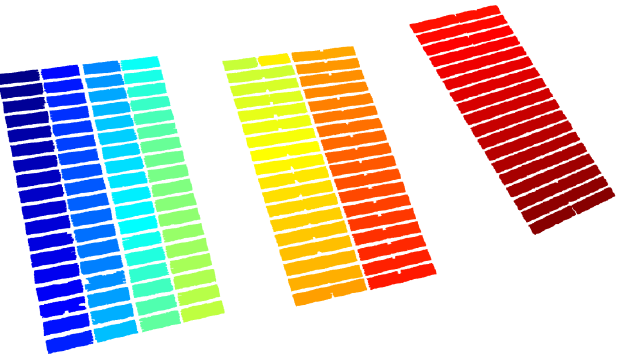
Figure 12. Photograph of the PV panels in which there is a horizontal fault in the tracker of the right PV module.